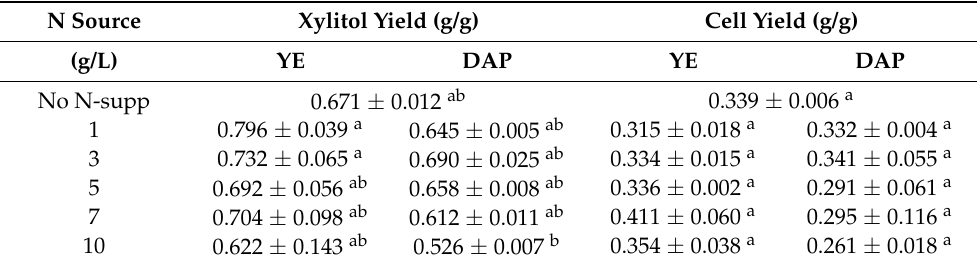
Table 1. Xylitol yields and cell yields obtained from 60-h xylitol fermentation by C. guilliermondii TISTR5068 using vinasse supplemented with yeast extract (YE) or diammonium phosphate (DAP). N Source Xylitol Yield (g/g) Cell Yield (g/g) (g/L) YE DAP YE DAP No N-supp 0.671 ± 0.012